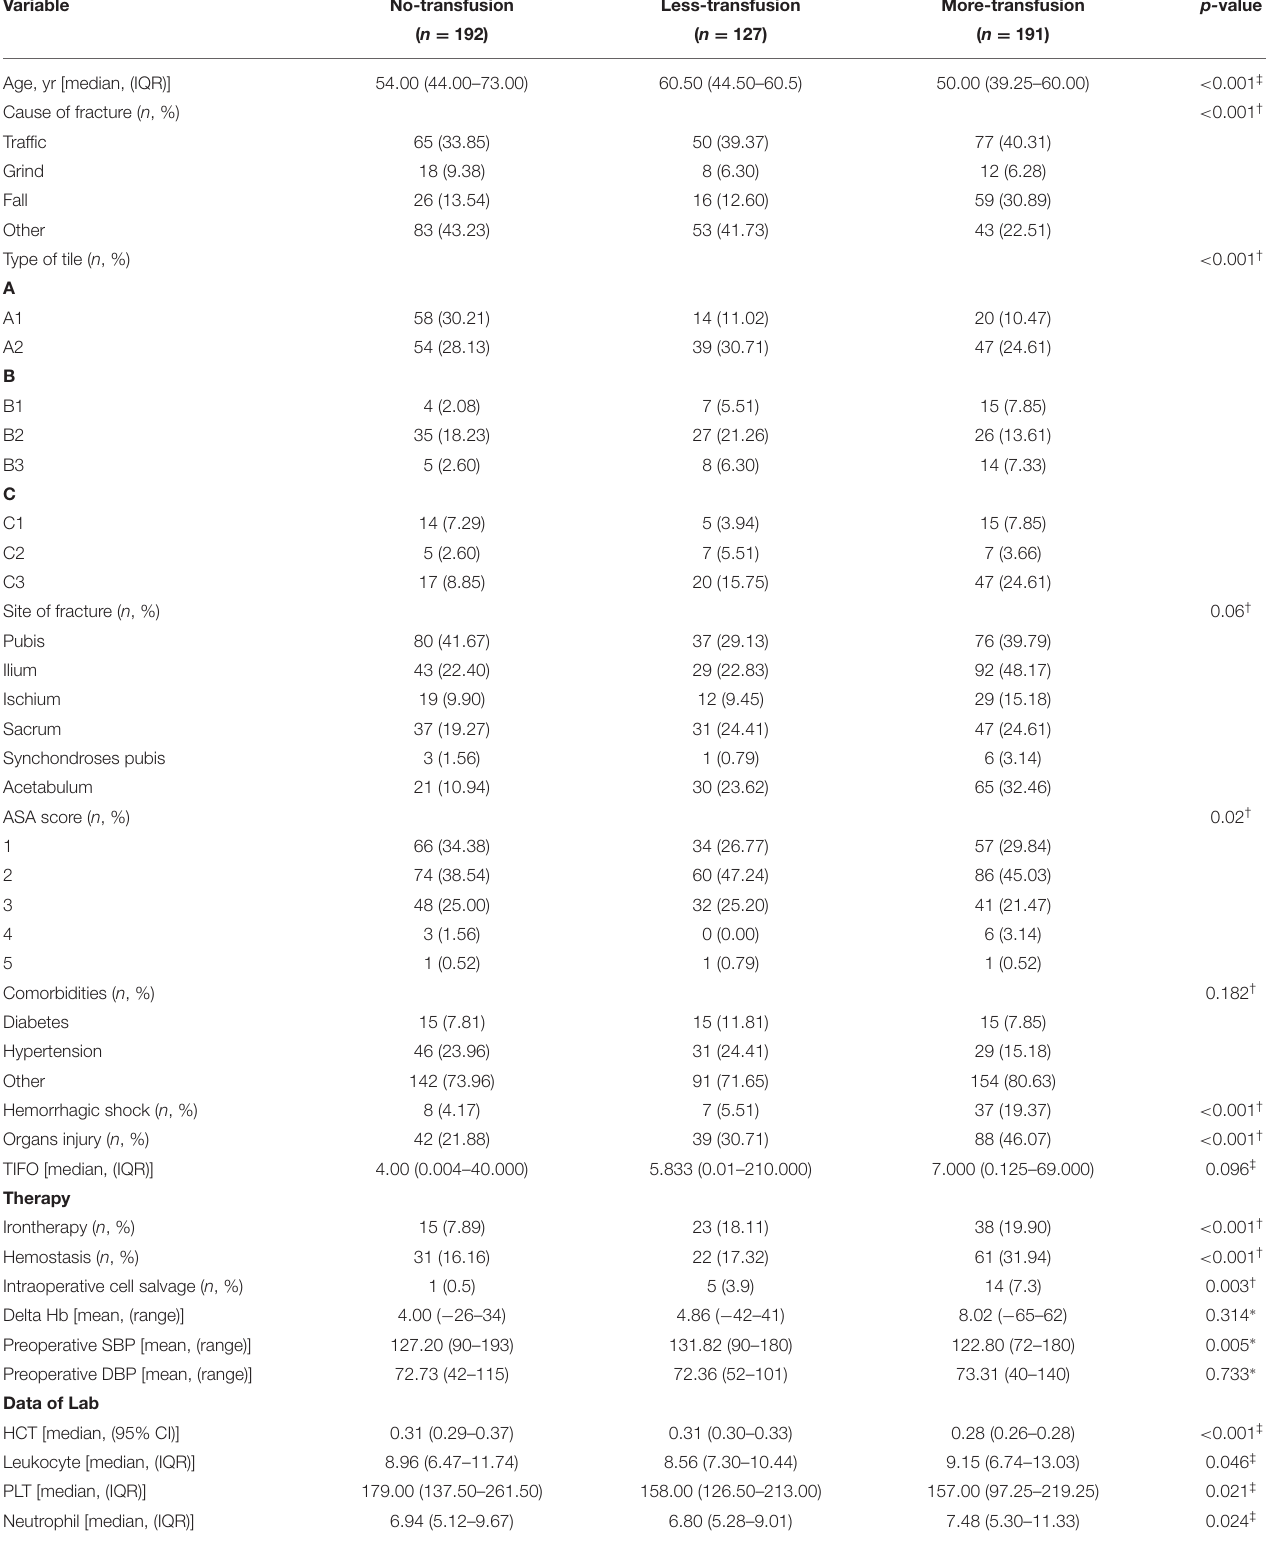
TABLE 1 | Clinical characteristics of the variables in transfusion predictive model and key features.